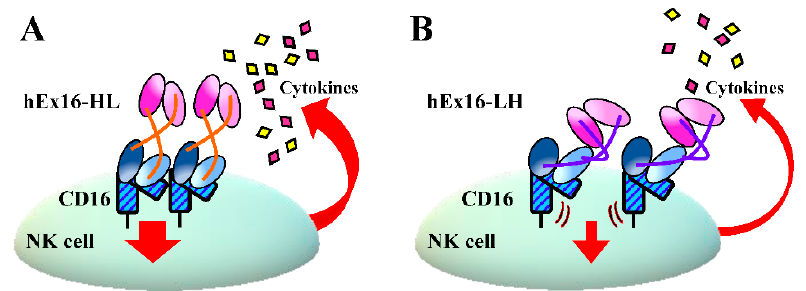
Figure 6. A proposed model for the differences in the activation of NK cells mediated by hEx16-Dbs binding. ( A ) The binding of hEx16-HL does not inhibit CD16 dimerization and facilitates induction of intracellular signaling. ( B ) The binding of hEx16-LH causes steric hindrance in CD16 dimerization and weakens the intracellular signaling.